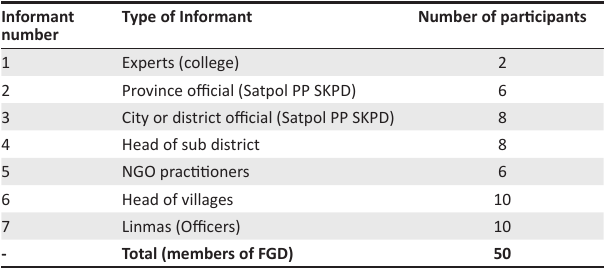
TABLE 2 : Number and types of informants from those involved in focus group discussions. Informant